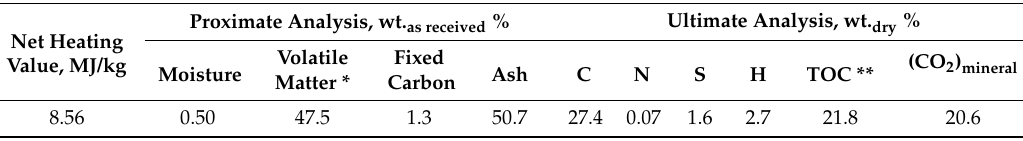
Table 1. Proximate and ultimate analysis of the oil